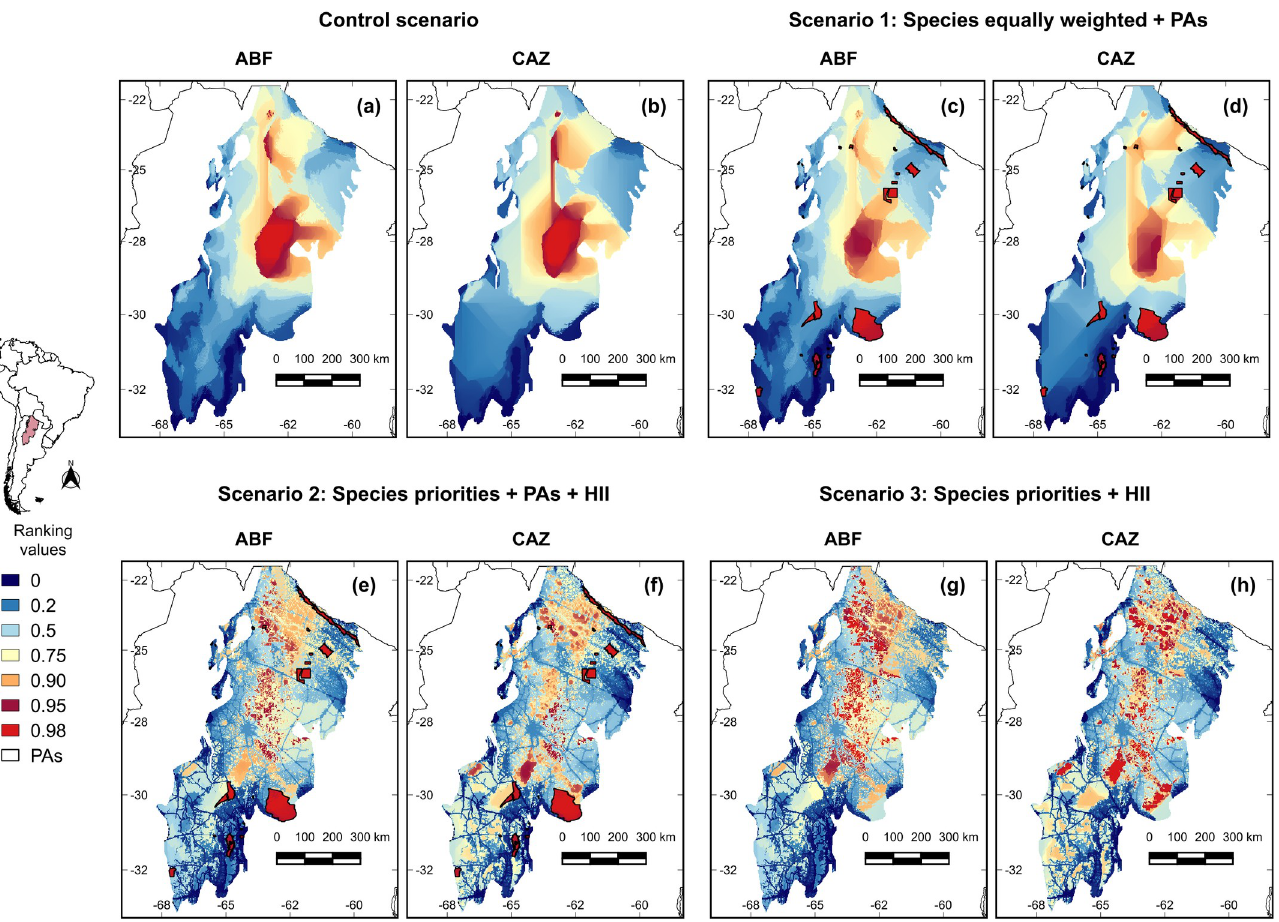
Fig 4. Priority areas for focal snakes distributed in the Argentinian Dry Chaco under different prioritization scenarios. In all scenarios we compared the outputs that emphasized species richness minimizing extinction risk [Added Benefit Function, ABF (left)] and emphasized areas with both the highest suitability scores and the lowest uncertainty values for each species [Core Area Zonation CAZ (right)]. (a-b) Control scenario (species equally weighted); (c-d) Scenario 1: species equally weighted + PAs; (e–f) Scenario 2: species individual weighted + PAs + cost (Human Footprint—HII); (g-h) Scenario 3: species individual weighted + cost (HII). The color scheme shows the nested ranking on a map. Ranking the biological value of the site: 2% high priority (light red); 2–5% (dark red); 5–10% (orange); 10–25% (yellow); 25–50% (light blue); and 50–80% (blue); 80–100% (or the least valuable 20%) (dark blue).